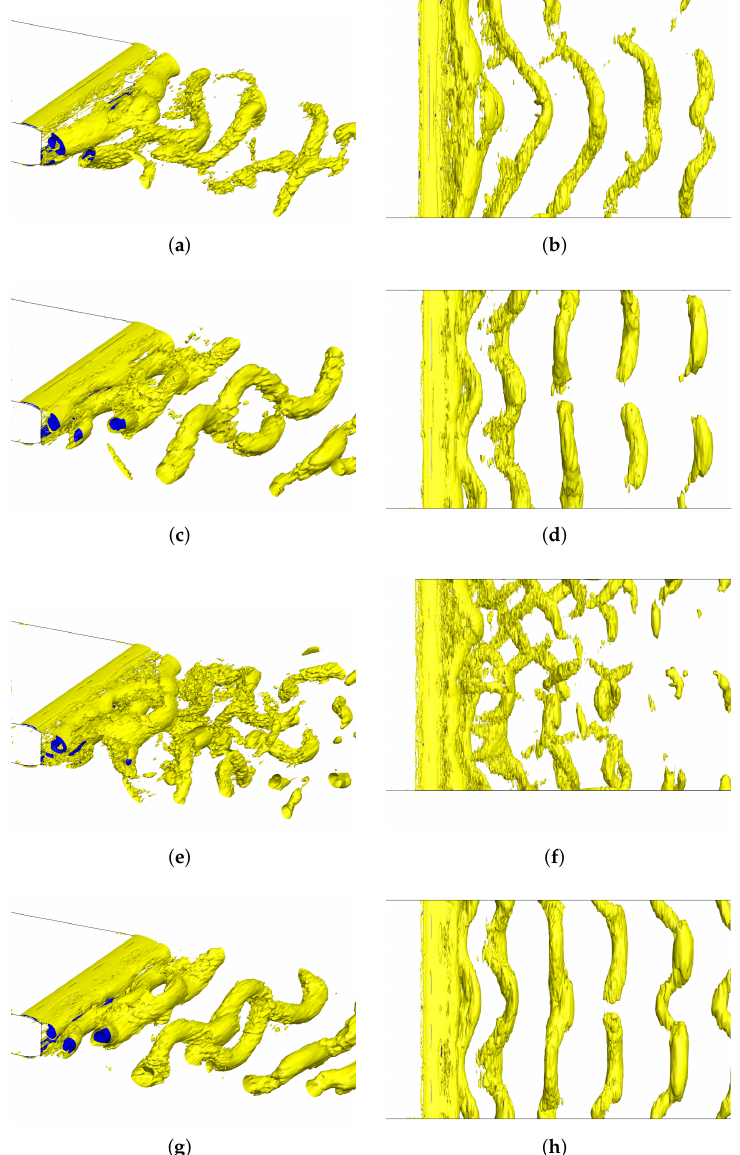
Figure 10. The 3D isometric (left side) and 2D top view (right side) of the instantaneous vortex indicator λ 2 for the spanwise-discontinuous grooves with: ( a , b ) N = 1, ( c , d ) N = 2, ( e , f ) N = 3, and ( g , h ) N =